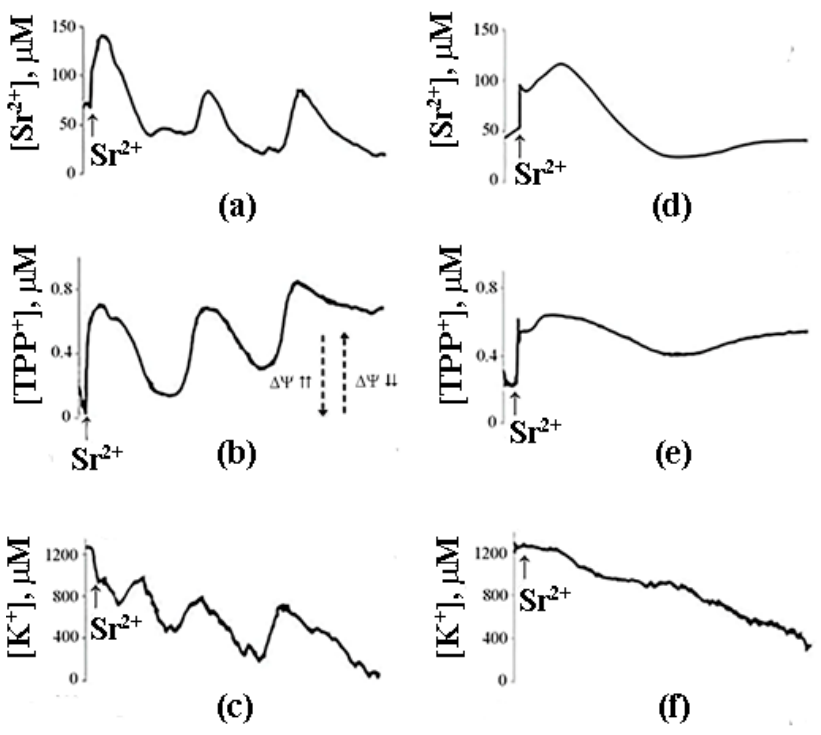
Figure 8. Sr 2+ /valinomycin-induced spontaneous changes in the external concentration of Sr 2+ , TPP + , and K + ions in the suspension of rat liver mitochondria in the absence ( a – c ) or presence ( d – f ) of the inhibitor of Ca 2+ (Sr 2+ )-dependent phospholipase A 2 , aristolochic acid (25 µ M). Addition: 45 nmol SrCl 2 /mg mitochondrial protein. The medium was the same as in Figure 5 but in the presence of 1 ng/mg valinomycin/protein. The concentration of the mitochondrial protein in the cuvette was 2 mg/mL. Typical curves are shown ( n =